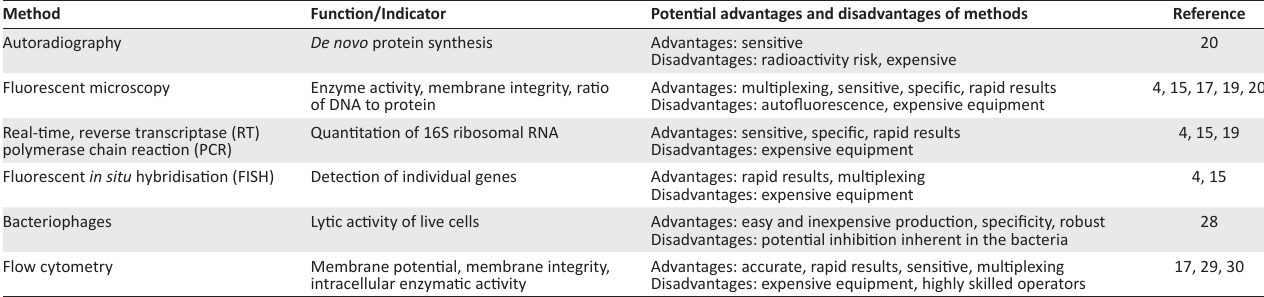
TABLE 1: Methods of detection of viable but non-culturable bacteria. Method Potential advantages and disadvantages of